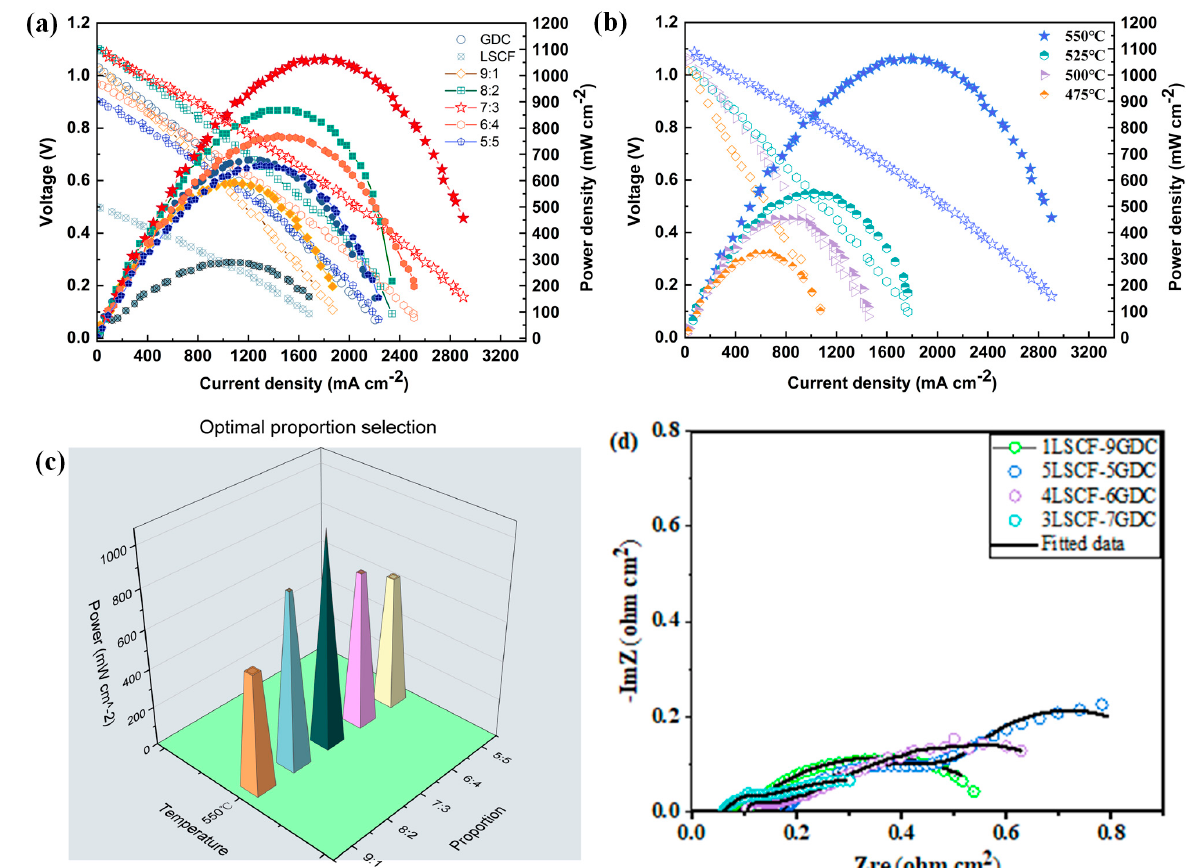
Figure 4. Typical I − V and I − P characteristic curves utilizing ( a ) pure LSCF, GDC, 1LSCF − 9GDC, 8LSCF − 2GDC, 3LSCF − 7GDC, 4LSCF − 6GDC, and 5LSCF − 5GDC operating at 550 °C ( b ) I − V